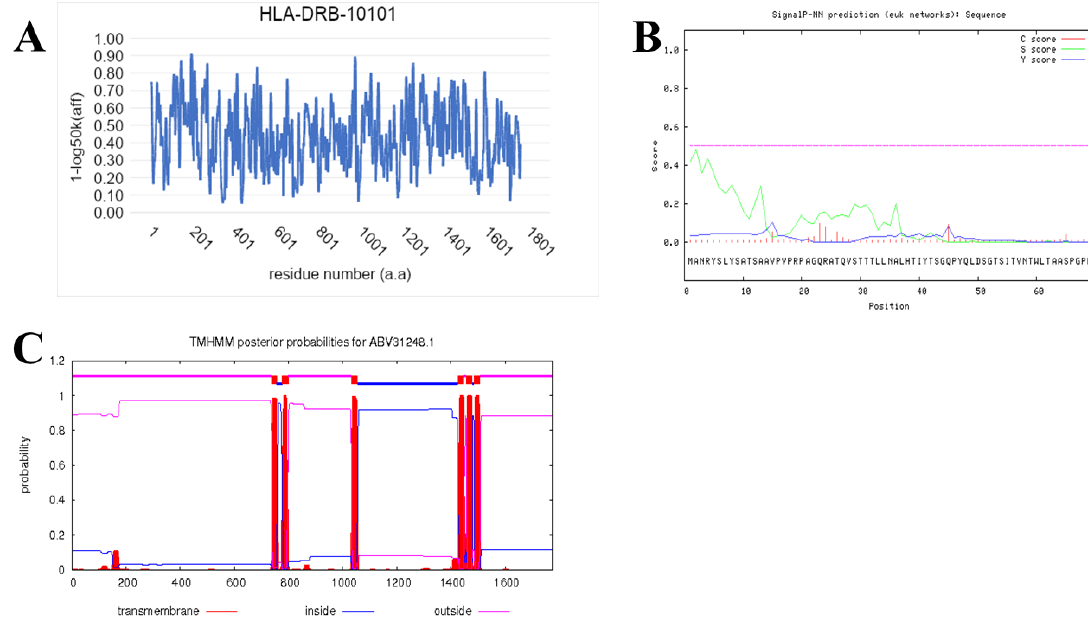
Figure 2. Analysis of the interaction of class VI protein chitin synthase (>ABV.31248.1) by integrating different algorithms. ( A ) Signal peptide prediction (Signal peptide). ( B ). Prediction of transmembrane regions (TMHMM). ( C ). Prediction of epitopic regions for MHC II (NetMHCII).